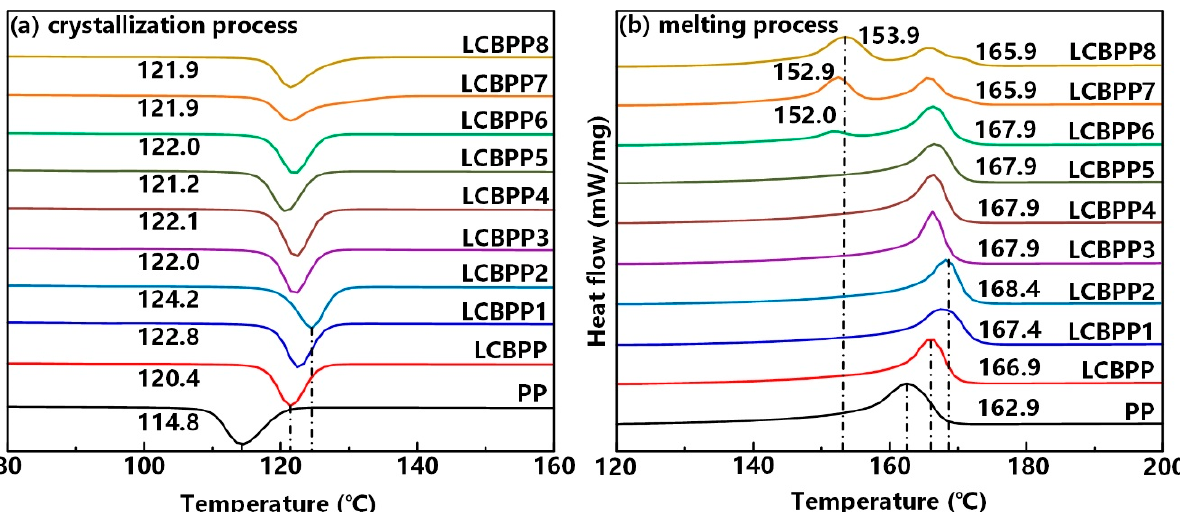
Figure 4. X-ray diffraction pattern of the test samples.